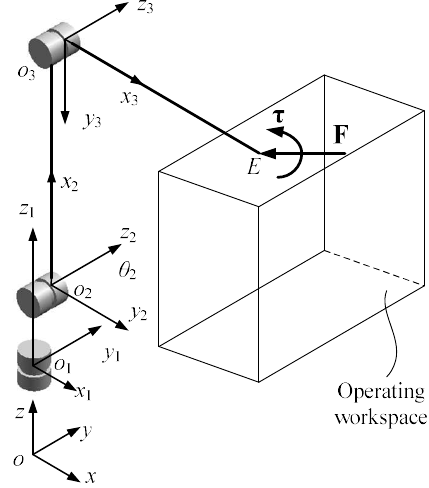
Figure 3. Reference frames for simulated robot.